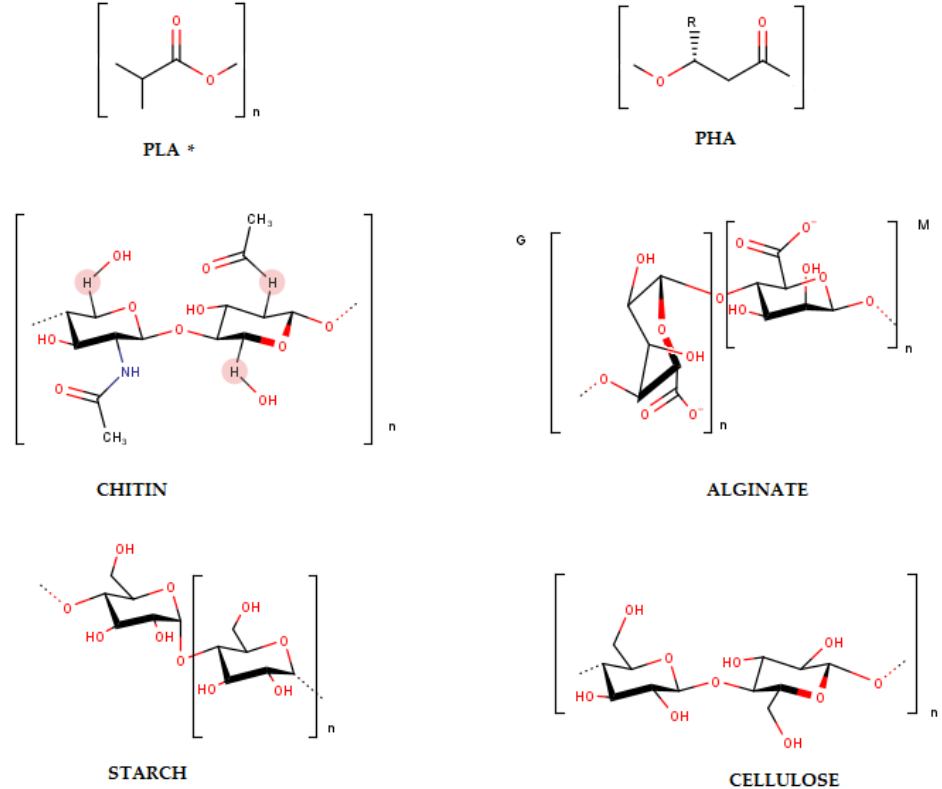
Figure 11. The chemical structures of bio-based biodegradable polymers (PLA* is a synthetically produced bio-based polymer, whilst PHA, Chitin, Alginate, Starch and Cellulose are naturally produced bio-based polymers) [98–100].